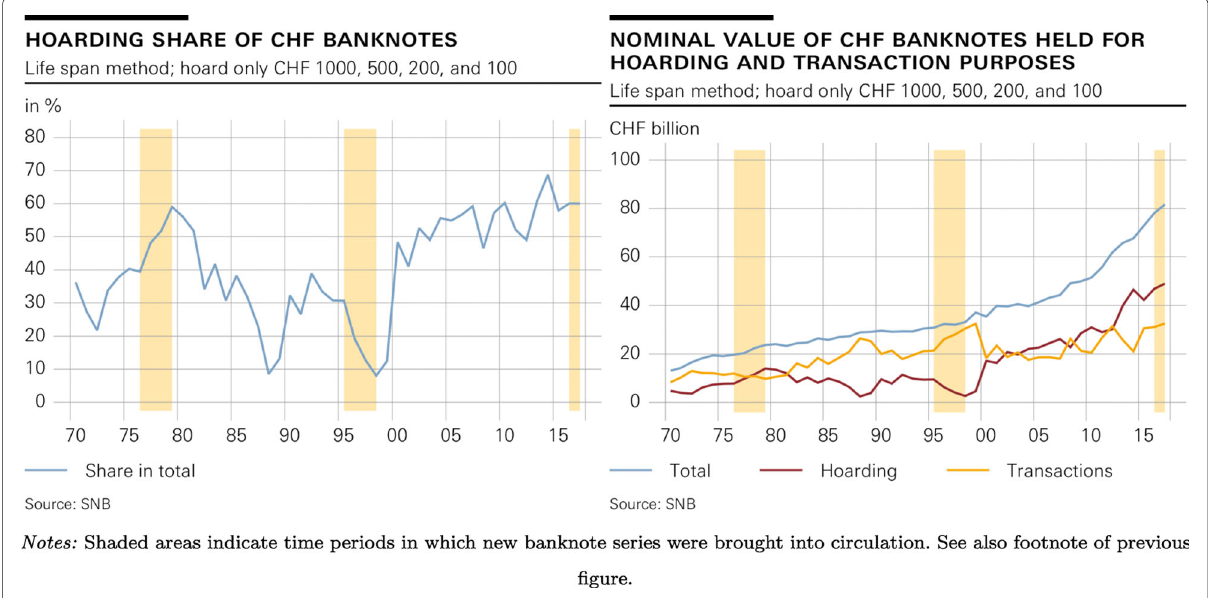
Fig. 8 Method based on life span - results for total banknotes